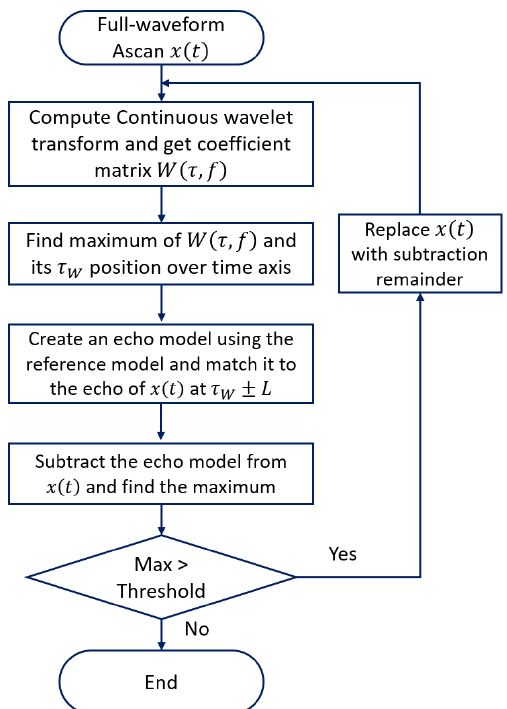
Figure 2. Flowchart of our baseline echo localization